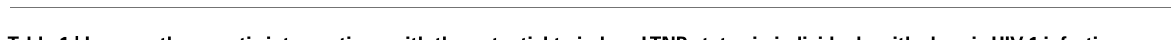
Table 1 | Immunotherapeutic interventions with the potential to induce LTNP status in individuals with chronic HIV-1 infection. Treatment